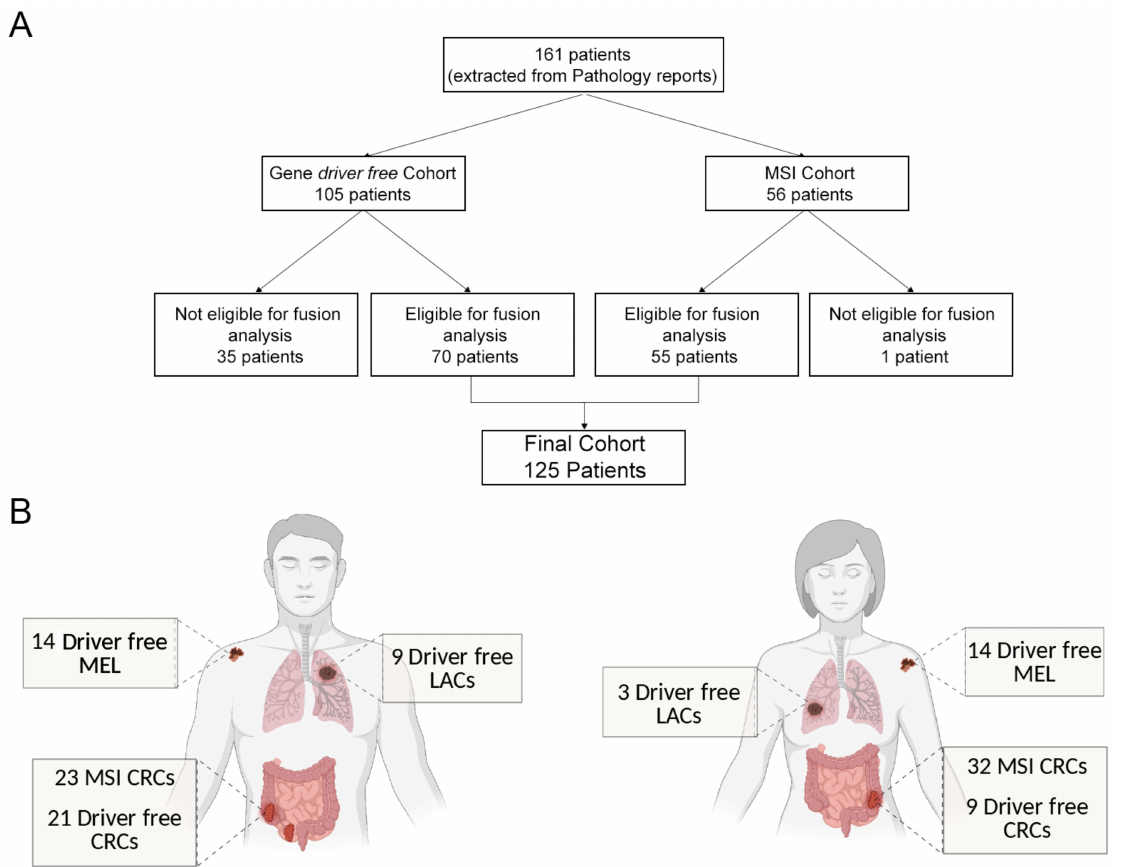
Figure 1. Representation of the “real-world” cohort of the study. ( A ) From an initial population of 161 patients, the histopathological review excluded samples without sufficient tumour cell content. Seventy tumour samples “gene driver free” and 55 MSI cases were eligible for RNA extraction and analysis, leading to a final cohort of 125 patients. ( B ) Final cohort composition: number of melanoma (MEL), colorectal cancer (CRC), and lung adenocarcinoma (LAC) patients according to gender, subdivided in “gene driver free”, and microsatellite instable (MSI)